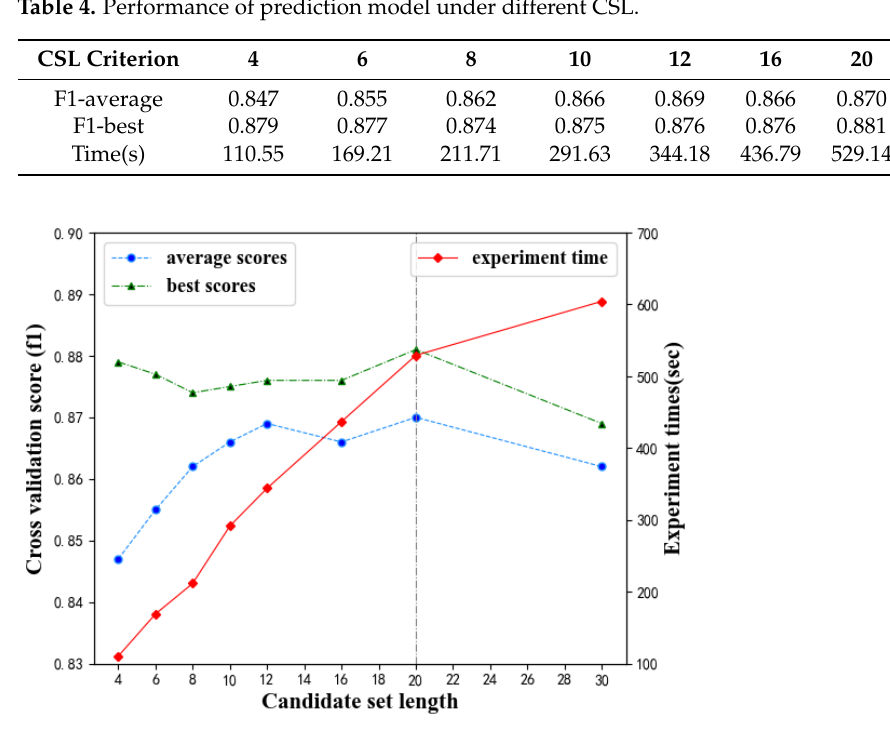
Figure 12. Effect of CSL on prediction model performance.